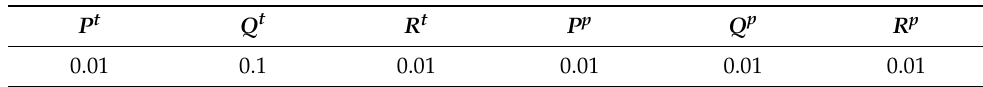
Table 4. DEKF initial parameter setting.